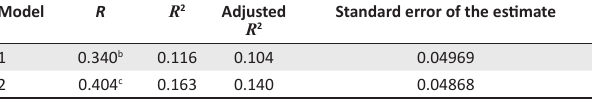
TABLE 2b: Stepwise linear regression results: Variables entered or removed a - model summary. Model